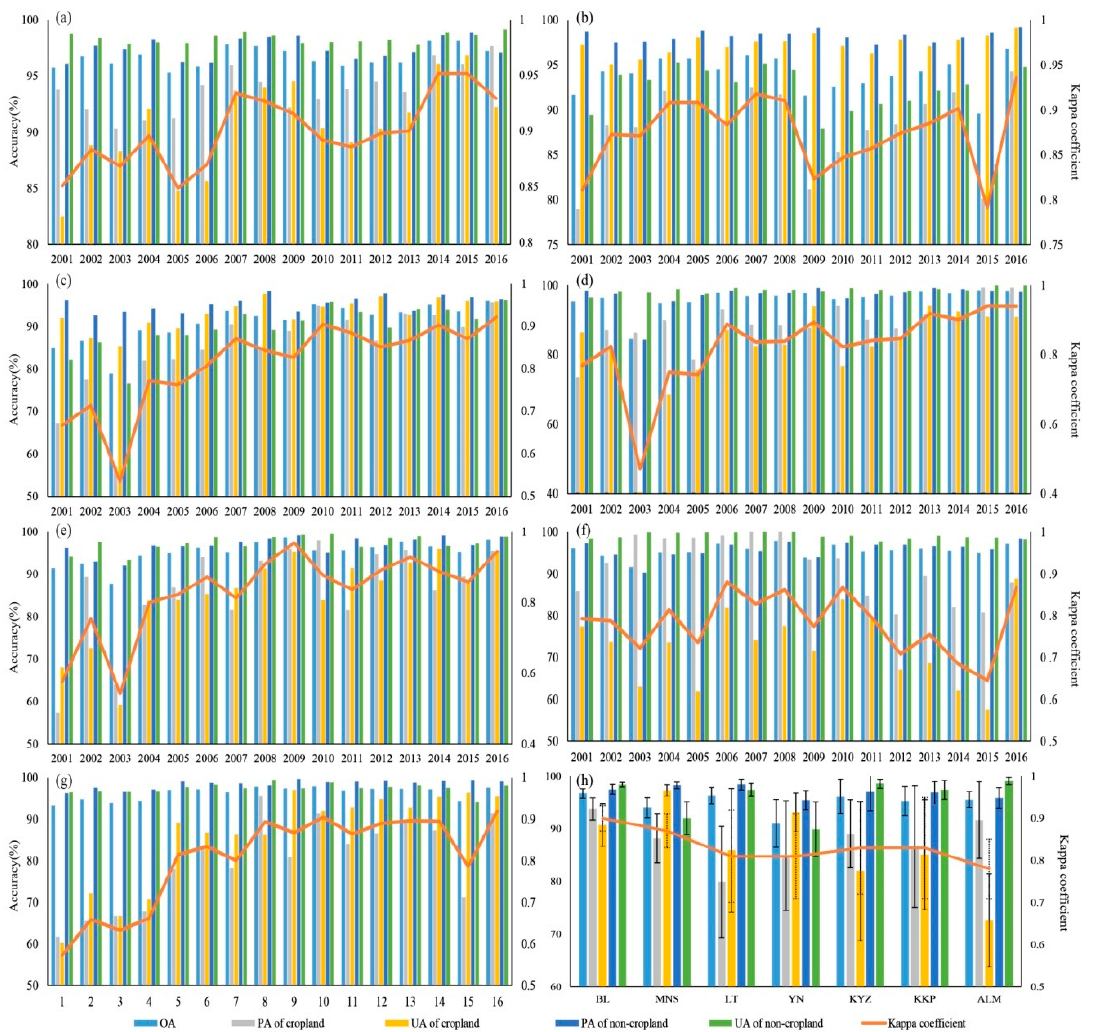
Figure 9. Classification accuracy of annual classifications in seven test sites. Notes: ( a ) BL, ( b ) MNS, ( c ) LT, ( d ) YN, ( e ) KYZ, ( f ) KKP, ( g ) ALM, ( h ) average and standard deviation of classification accuracy among the 16 years.